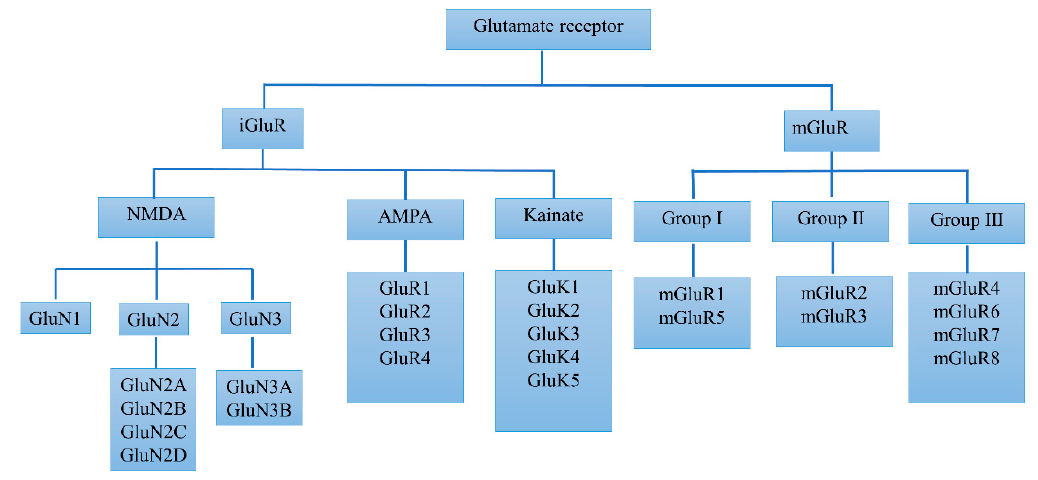
Figure 1. Classification of glutamate receptors.